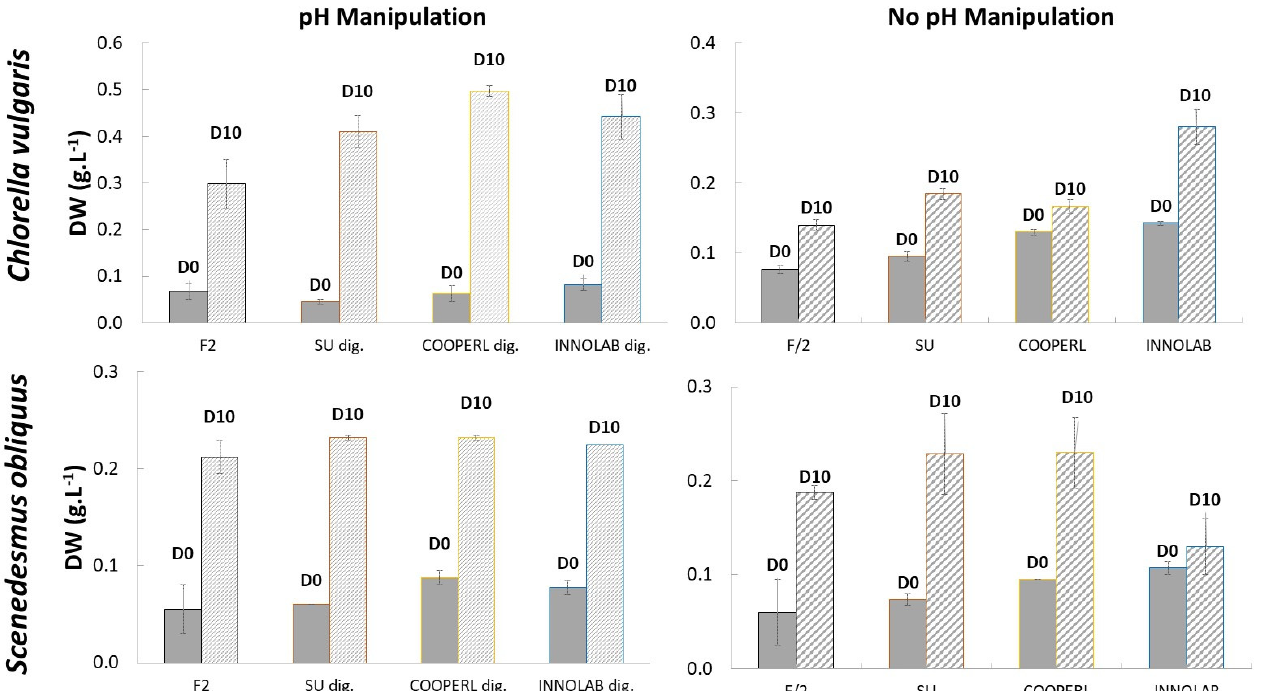
Figure 2. Dry weight of C. vulgaris and S. obliquus grown on three different digestates under pH manipulation and no pH manipulation on day 0 and 10 of the experiment. Error bars represent the standard deviation on three replicates.